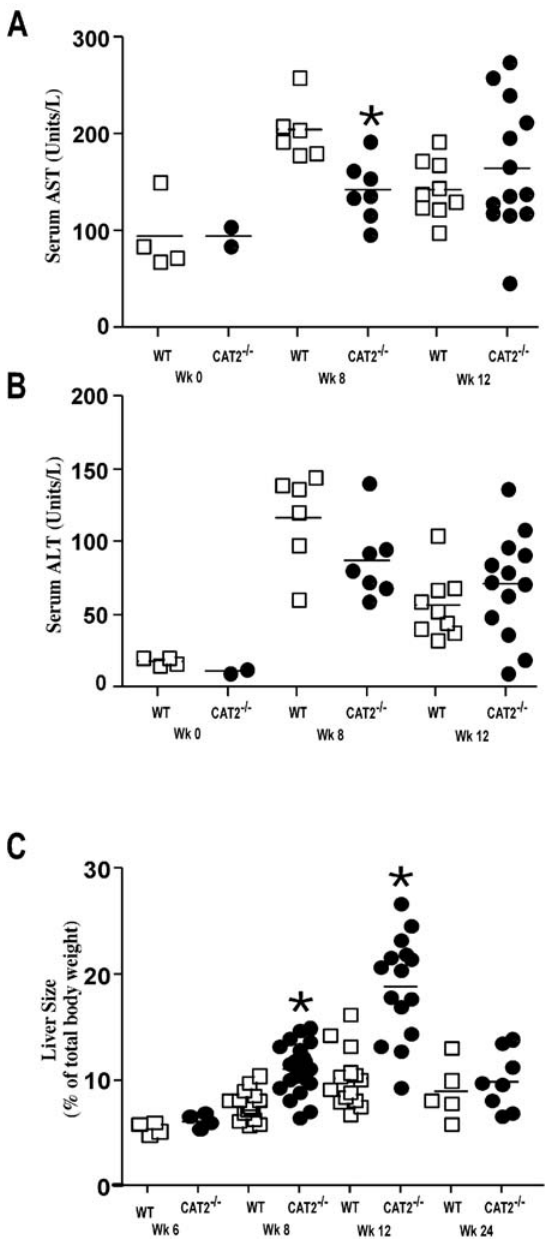
Figure 4. S.mansoni infected CAT2 2 / 2 mice develop marked hepatomegaly. A. Serum aspartate transaminase (AST) values in WT C57BL/6 and CAT2 2 / 2 mice (wk 0, 8, 12 post-infection). The * symbol denotes significant differences between WT and KO mice at that time point, p , 0.05. B. Serum alanine transaminase (ALT) values. C. Liver size as percentage of body weight at 6, 8, 12, and 24 wk post- S. mansoni infection.